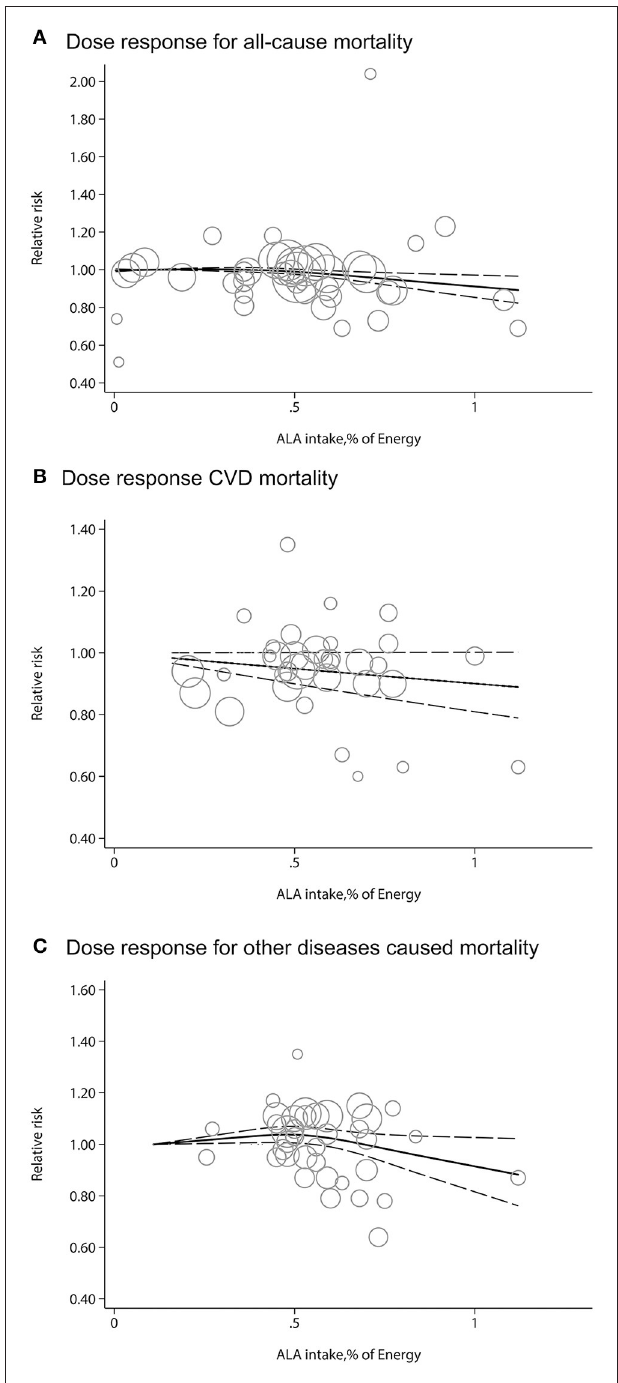
FIGURE 3 | Dose-response meta-analysis for associations between dietary ALA intake and mortality from all causes (A) , CVD (B) and other diseases (C) in prospective cohort studies. The pooled relative risk (RR) trend by ALA intake dosage (solid line) and its 95% CIs (dashed lines) was obtained by a random-effects dose-response meta-analysis. Circles represent RRs according to ALA categories from each study, inversely proportional to the variance of log RRs. CVD, cardiovascular